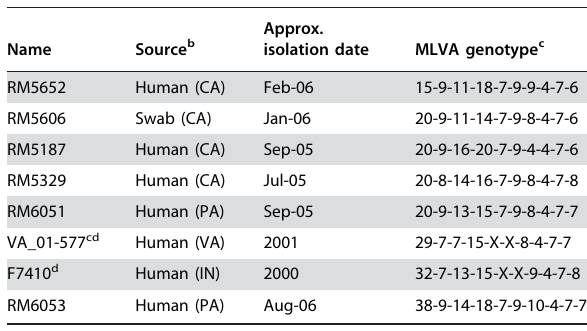
Table 2. MLVA differences between strains of the